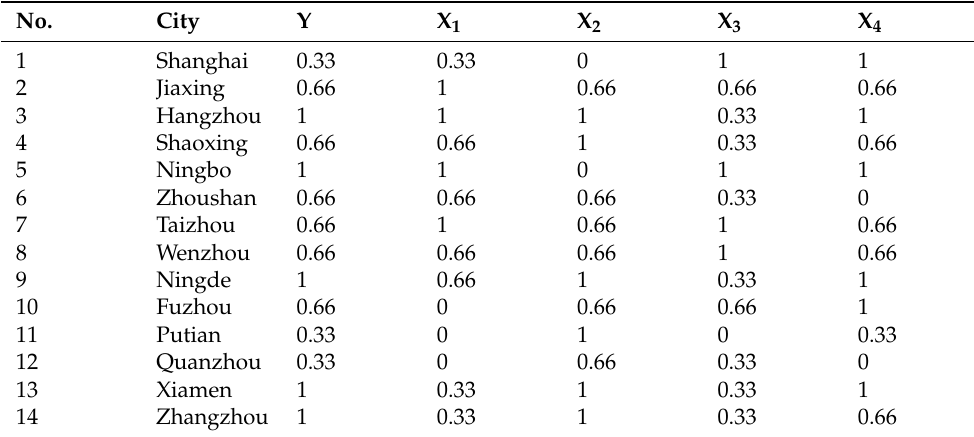
Table 4. Values for the conditions and outcome of the considered cases.